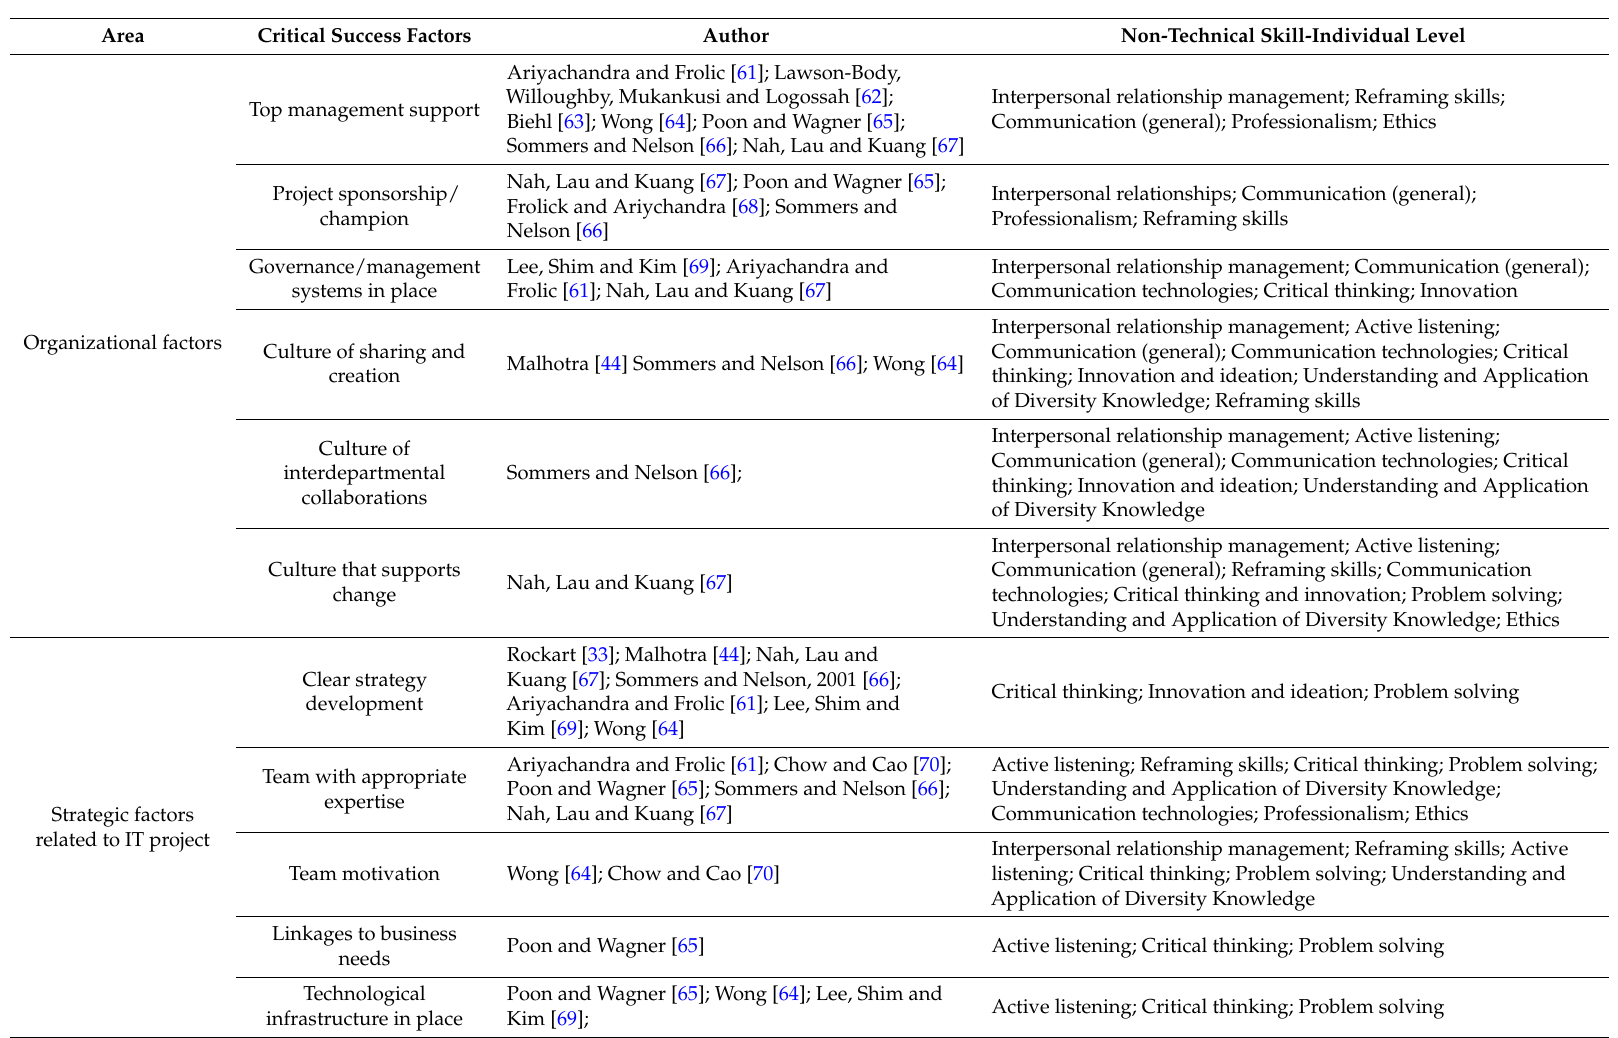
Table 2. Non-technical skills model as related to critical success